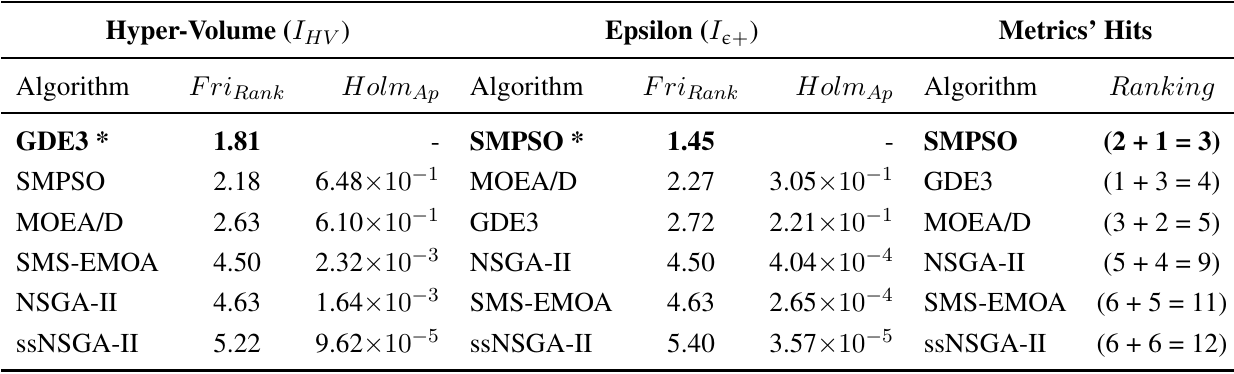
and I (cid:15) + HV